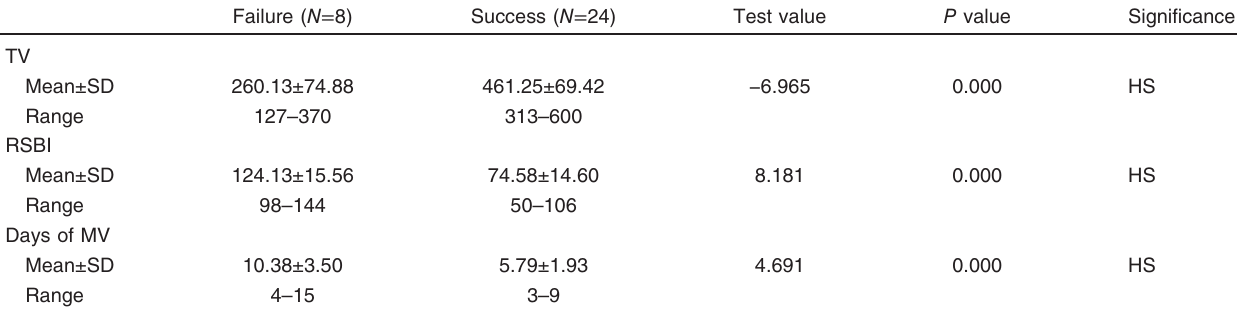
Table 3 Comparison between success and failure of weaning regarding tidal volume, rapid shallow breathing index, and days of mechanical